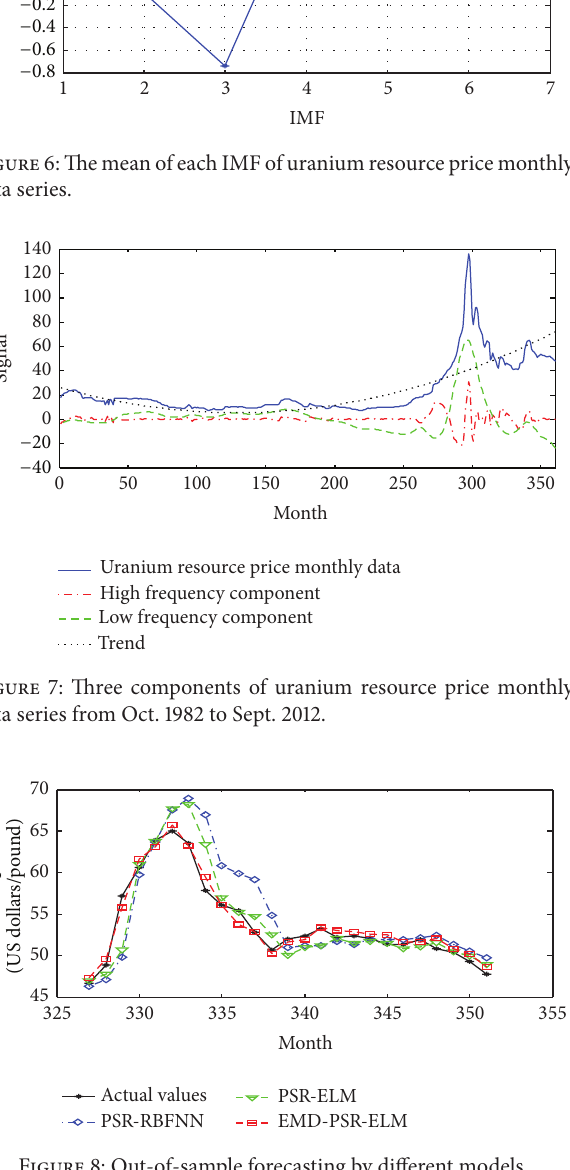
the remaining parameters. In PSR-ELM, the number of hidden nodes is set the same as the above.